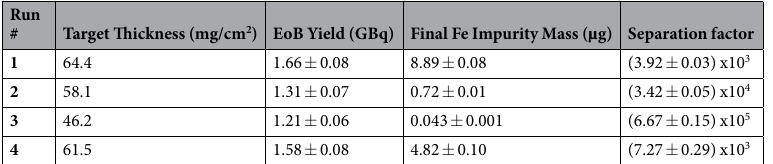
Table 1. 51 Mn irradiation yields and separation results from three representative production runs.